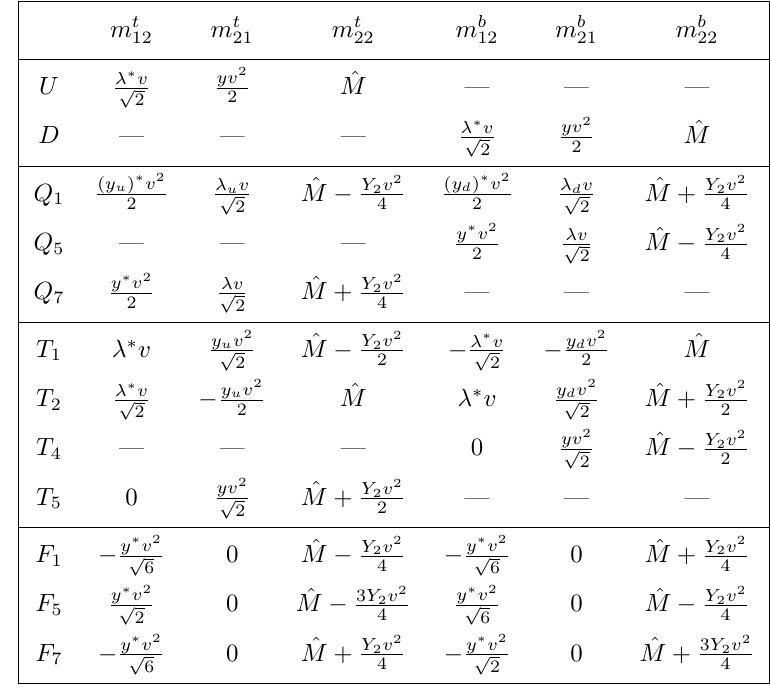
Table 2 . Mass matrix elements. We use the notation ^ M = M + Y 1 v 2 = 2. The 11 component